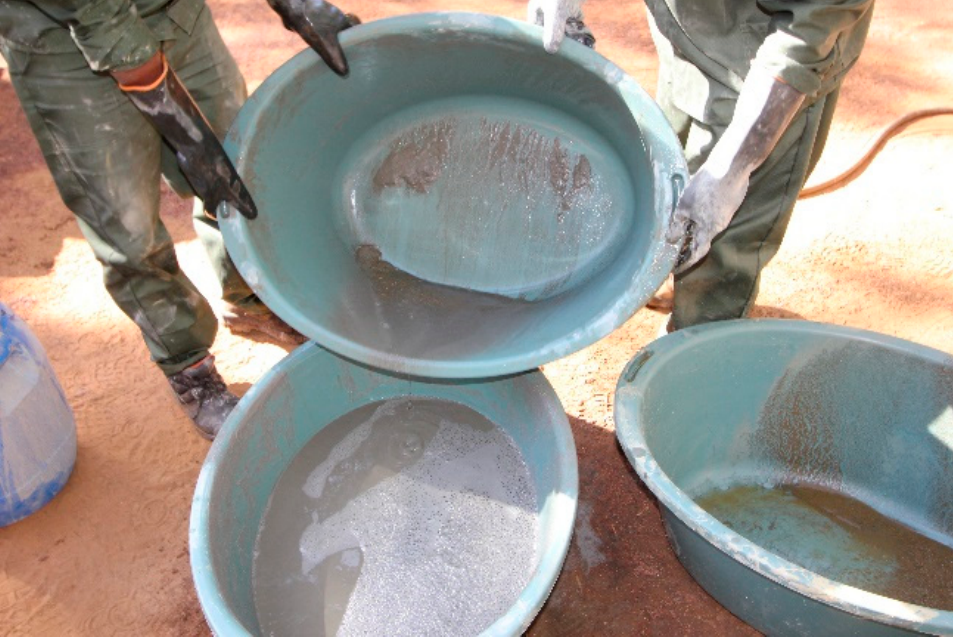
Figure 3. Decanting of the slurry to remove the low-density gangue minerals and fines.